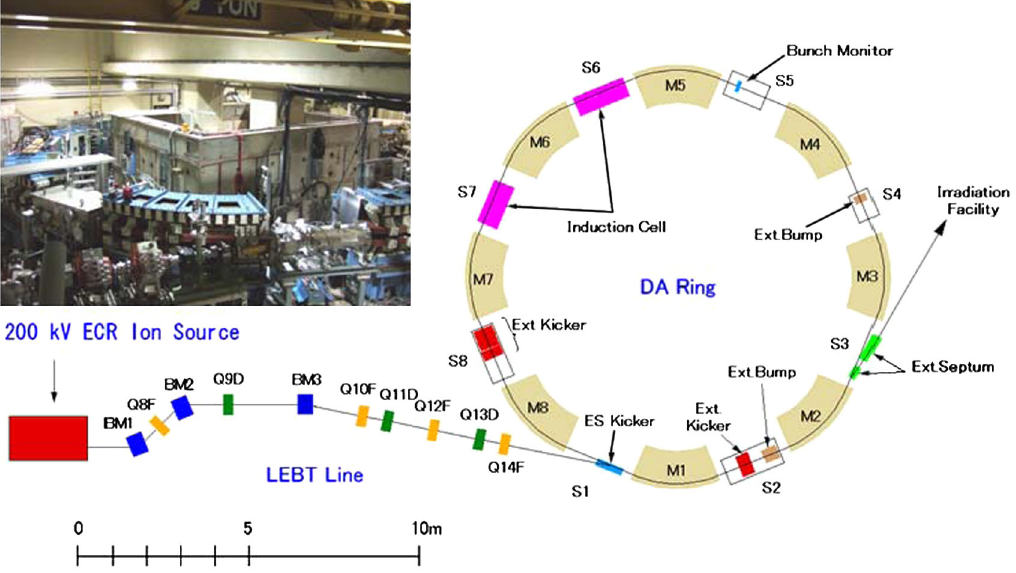
FIG. 2. Outline of the KEK digital accelerator and the recent photograph.